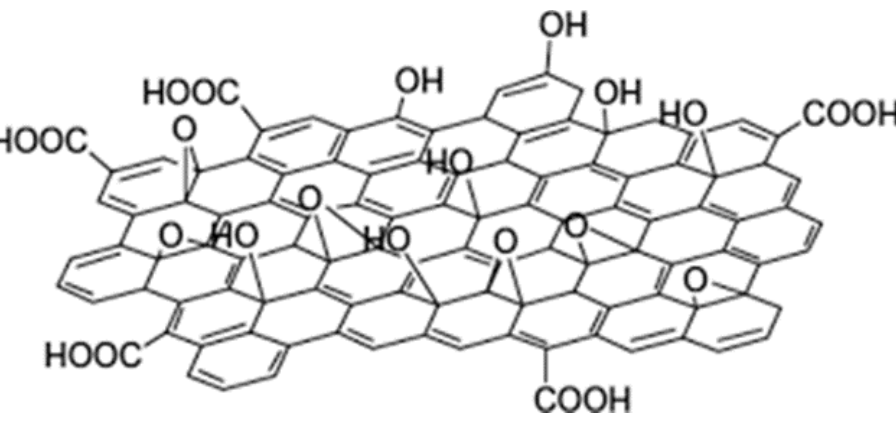
Figure 3. Typical structure of graphene oxide that shows various oxygen-containing functional groups [63]. (Adapted with permission from ref. [63]. Copyright 2015 RCS publishing.)